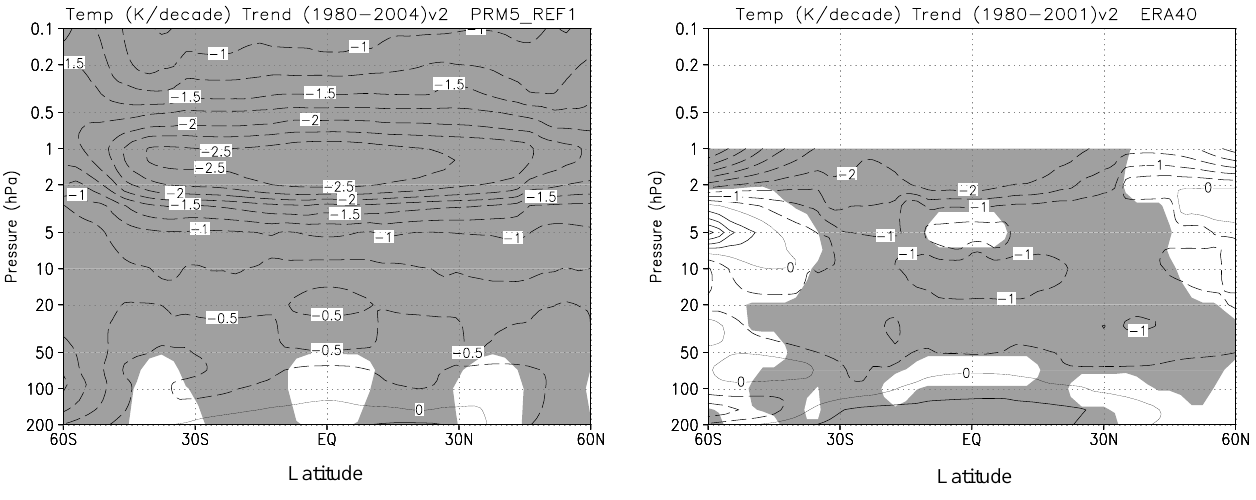
Fig. 9. Latitude-pressure cross sections of the temperature linear trend (K/decade) from 200 to 0.1hPa between 60 ◦ S and 60 ◦ N for the simulation (left) and observation (ERA-40) (right). Contour interval is 0.25K/decade for the simulation and 0.5K/decade for the observation. Shading denotes the area of the linear trend different from zero at the 95% confidence level (t-test).